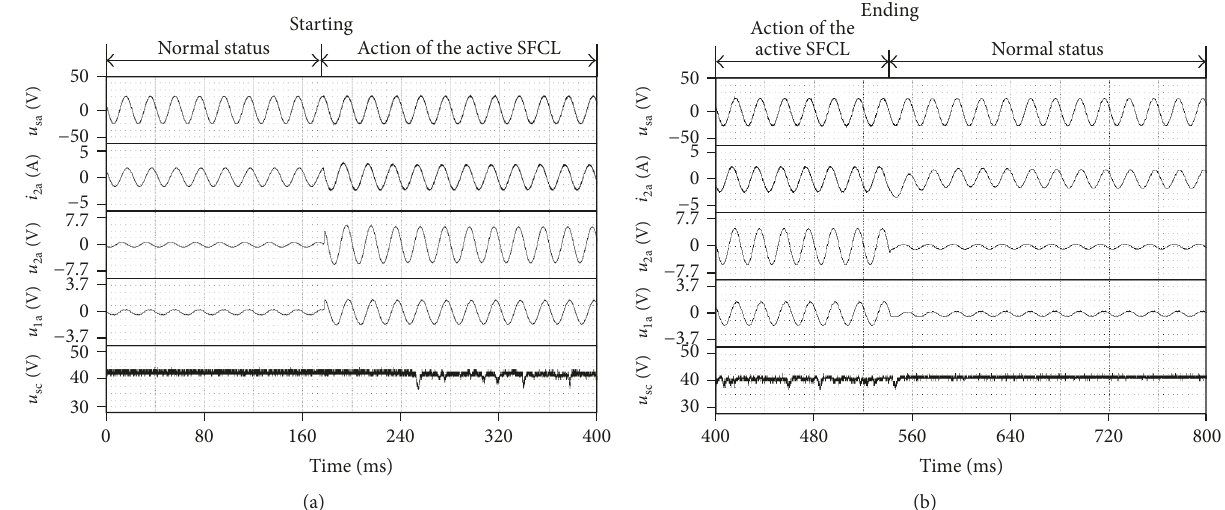
Figure 7: Performance of the active SFCL prototype under the commissioning test. (a) Starting characteristic and (b) ending characteristic.